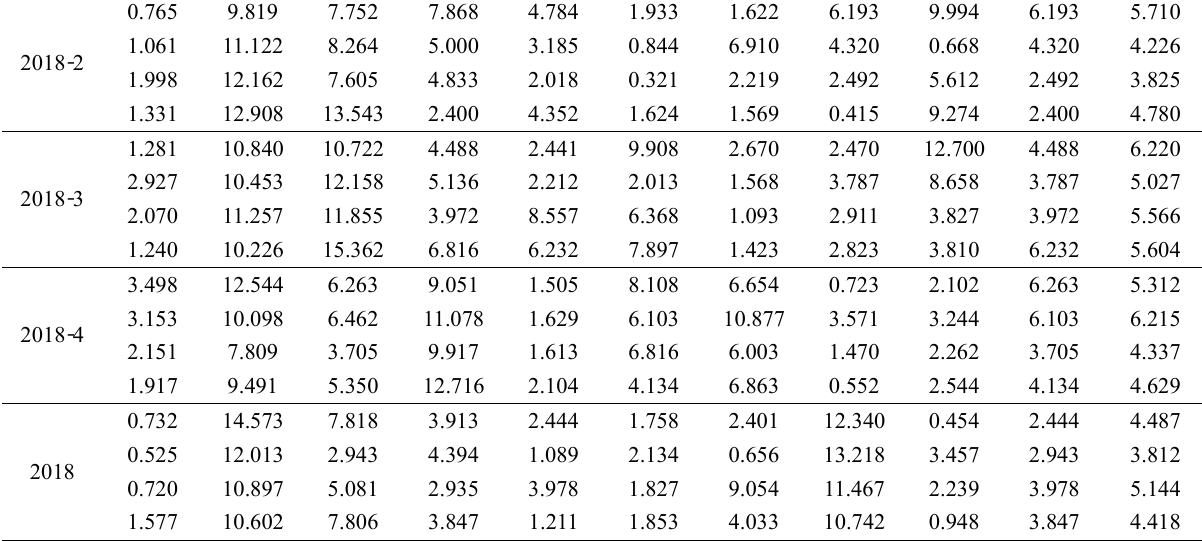
Table 3. The averages and medians of ΔE 00 in four colored patterns